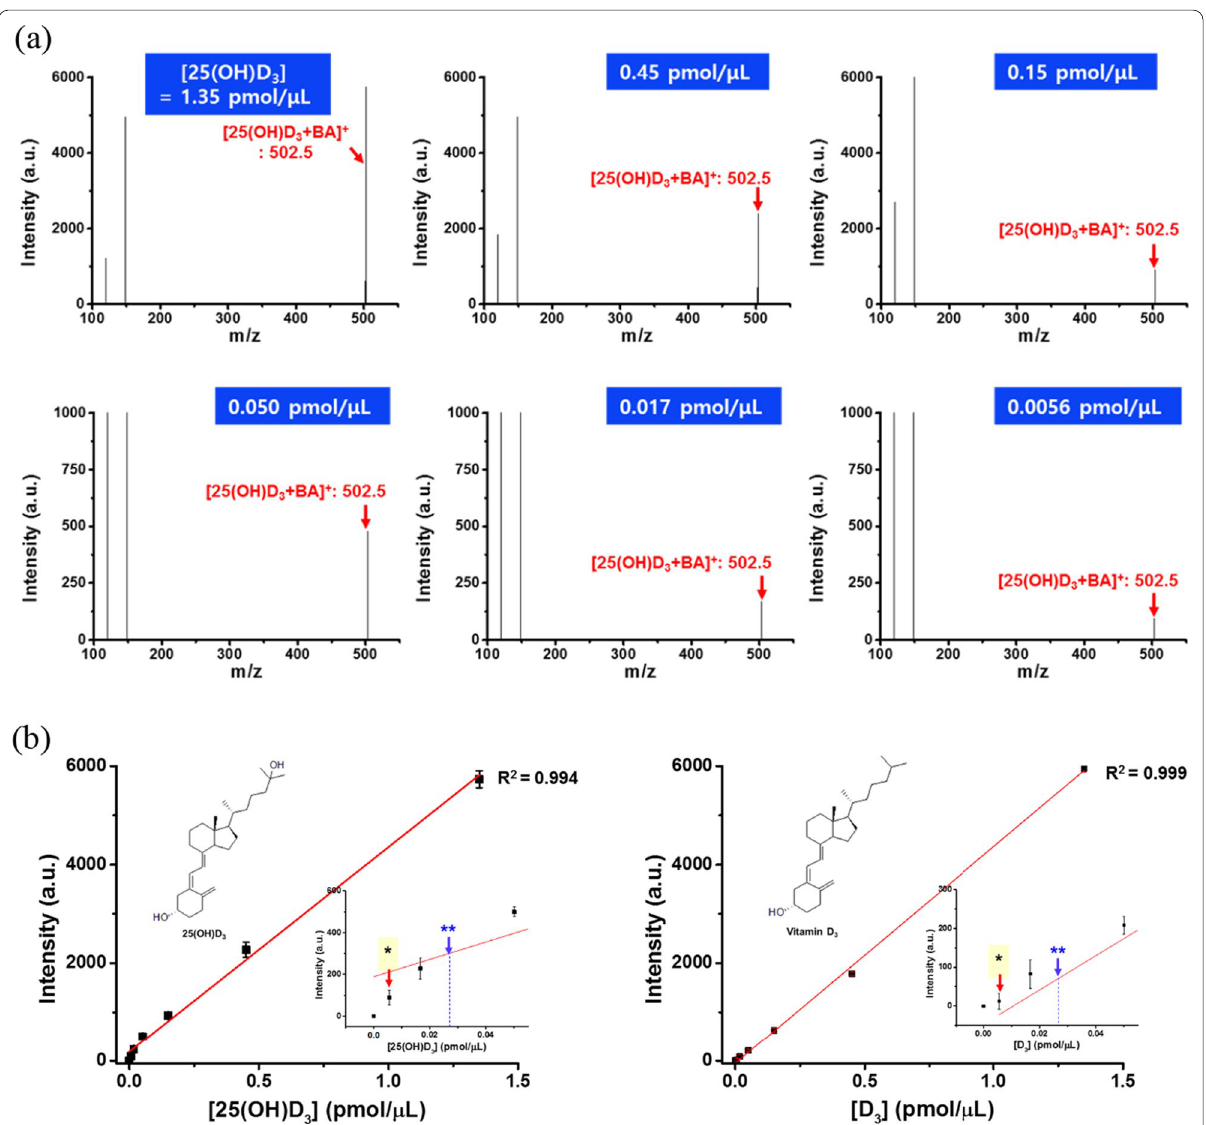
Fig. 5 Quantitative analysis of vitamin D using the parylene matrix chip. a Mass spectrum of 25(OH)D 3 in ethanol. b Standard curve of 25(OH)D 3 in ethanol. c Mass spectrum of 25(OH)D 3 in serum. d Standard curve of 25(OH)D 3 in